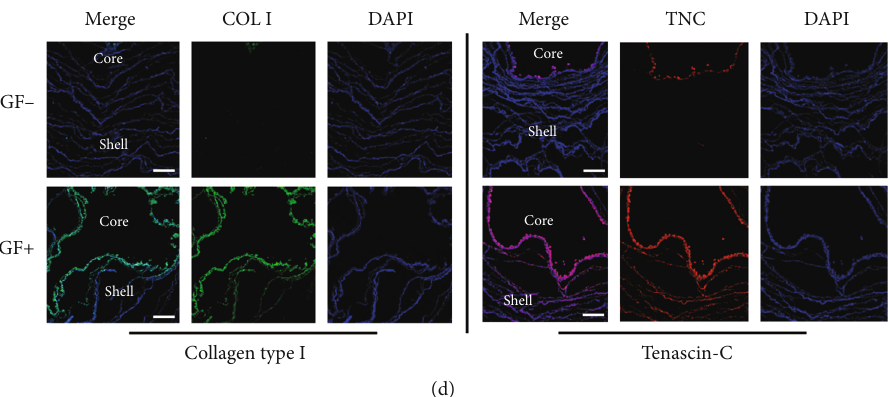
Figure 6: 3D electrospun nano fi ber-based sca ff olds for tendon and ligament regeneration. (a) Schematic illustration of fabrication and stimulation of composite sca ff old consisted of electrospun nano fi bers and cell-laden hydrogel coating crosslinked by Ca 2+ and UV light. Reproduced with permission from [129]. Copyright © 2019, American Chemical Society. (b) Electrospinning equipment for fabrication of silk fi broin-PCL nano/micro fi ber mat. (c) SEM images of cell-laden fi ber/hydrogel 3D composite construct (cross-section). (d) Immuno fl uorescent staining of collagen type I and tenascin-C in the hybrid constructs. Scale bar = 200 μ m. Copyright